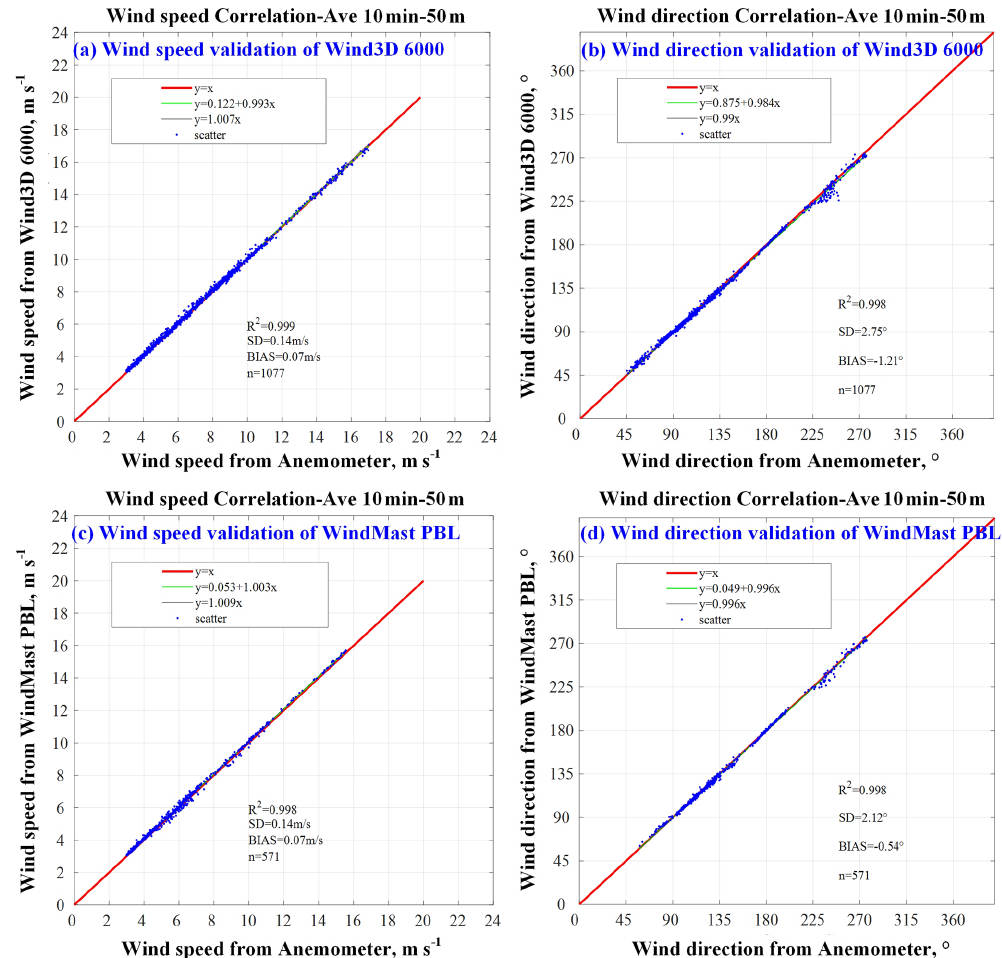
Figure 3. Evaluation tests of (a, b) Wind3D 6000 and (c, d) WindMast PBL performance by comparing their measurements against the conventional wind measurements with mast-mounted cup anemometers and wind